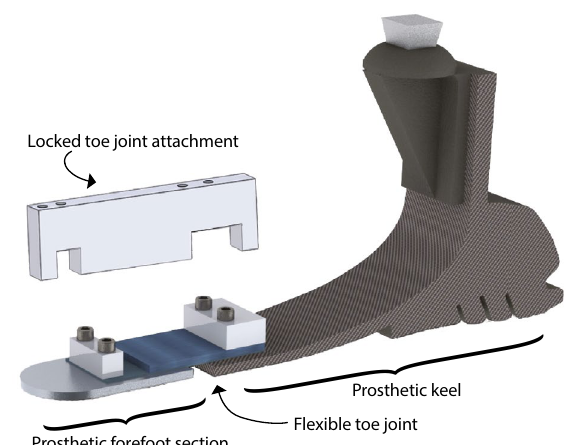
Figure 1. A custom-modified Össur Balance Foot J passive prosthesis shown in a Flexible toe joint configuration. The aluminum block attachment (above) can be secured over the joint to create a Locked-out toe joint